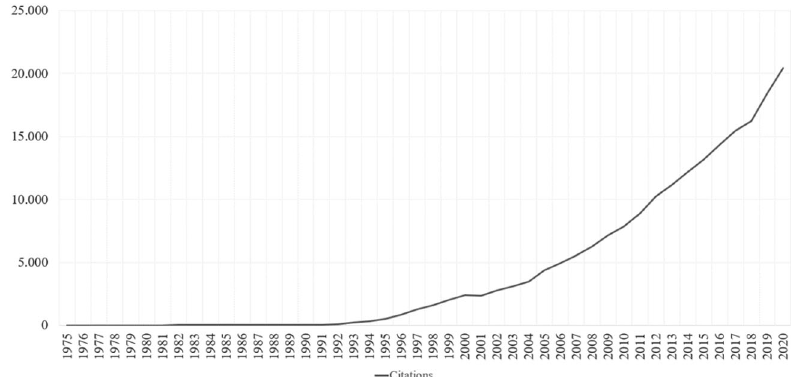
Fig. 7 Number of citations per year. Source: Web of Science,